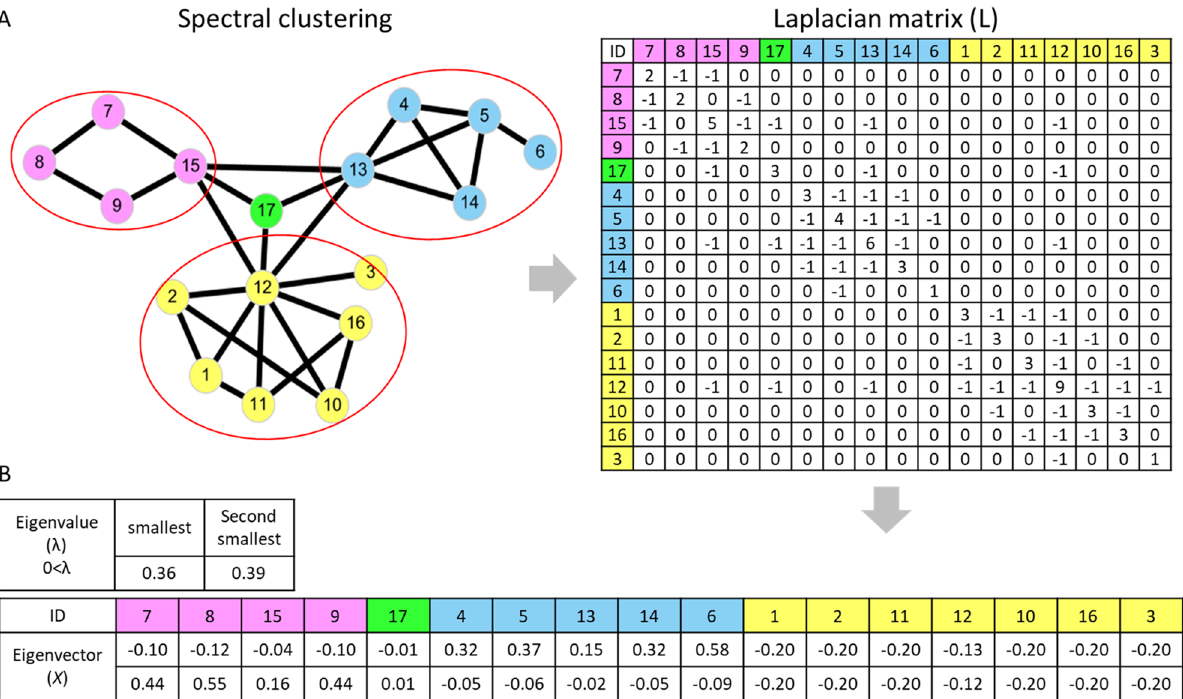
a diagonal cell is the degree of this node, whereas “− 1” indicates the interaction is existing between two nodes, such as cells between node 7 to node 8 and 15 were assigned value “− 1” in first row; otherwise, the cells are assigned value “0” if no interaction between two nodes. ( B ) The smallest and second smallest non-negative and non-zero eigenvalues with their corresponding eigenvectors were used as x–y axis to map PPI network to 2D